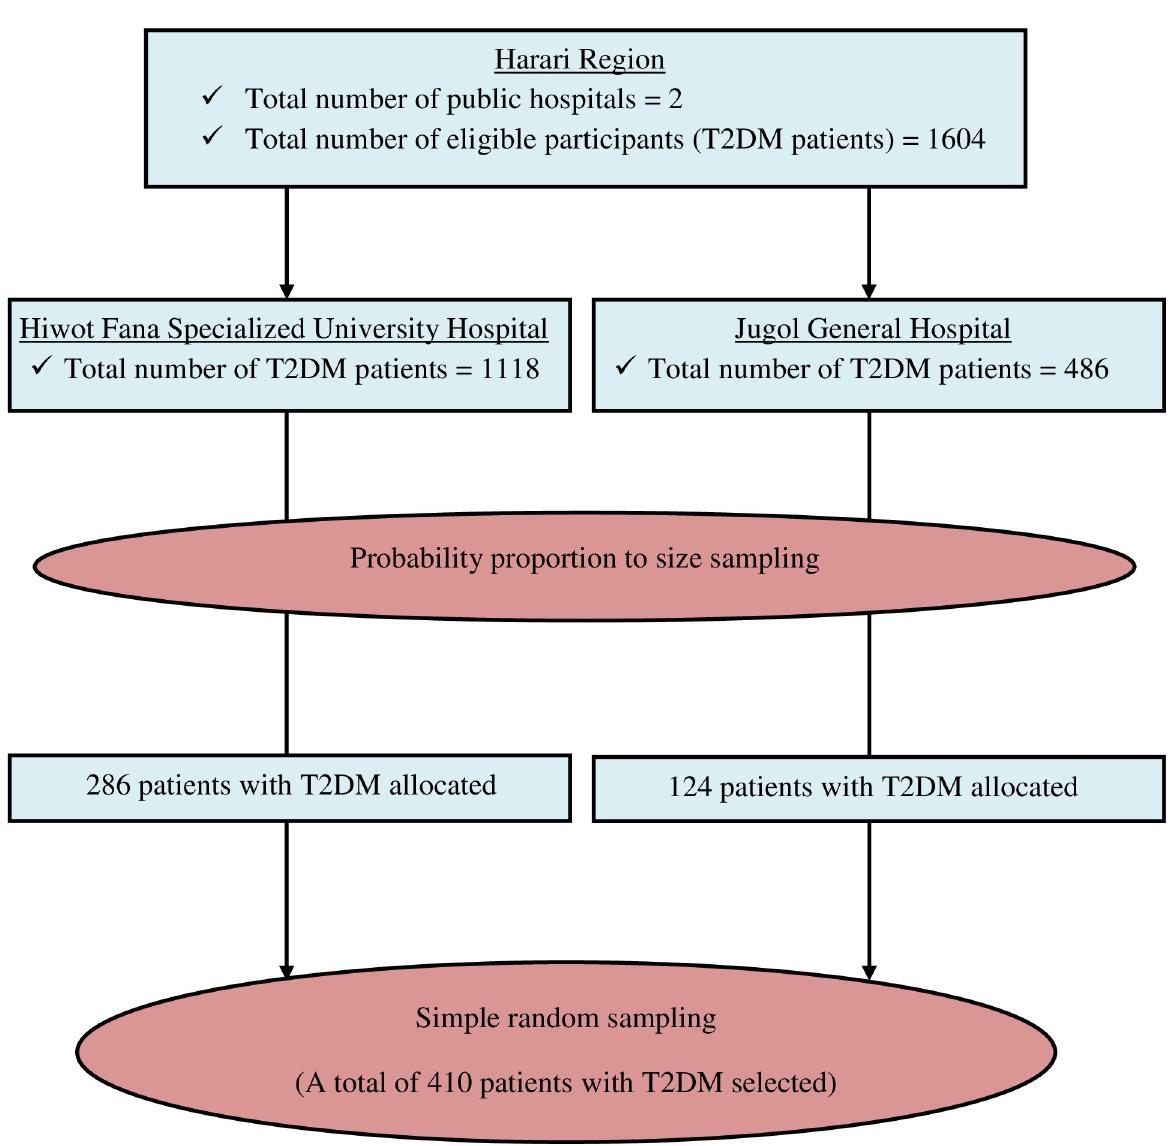
Fig 1. Schematic presentation of sampling procedure among T2DM patients attending public hospitals in Harari Region, Eastern Ethiopia, February to March